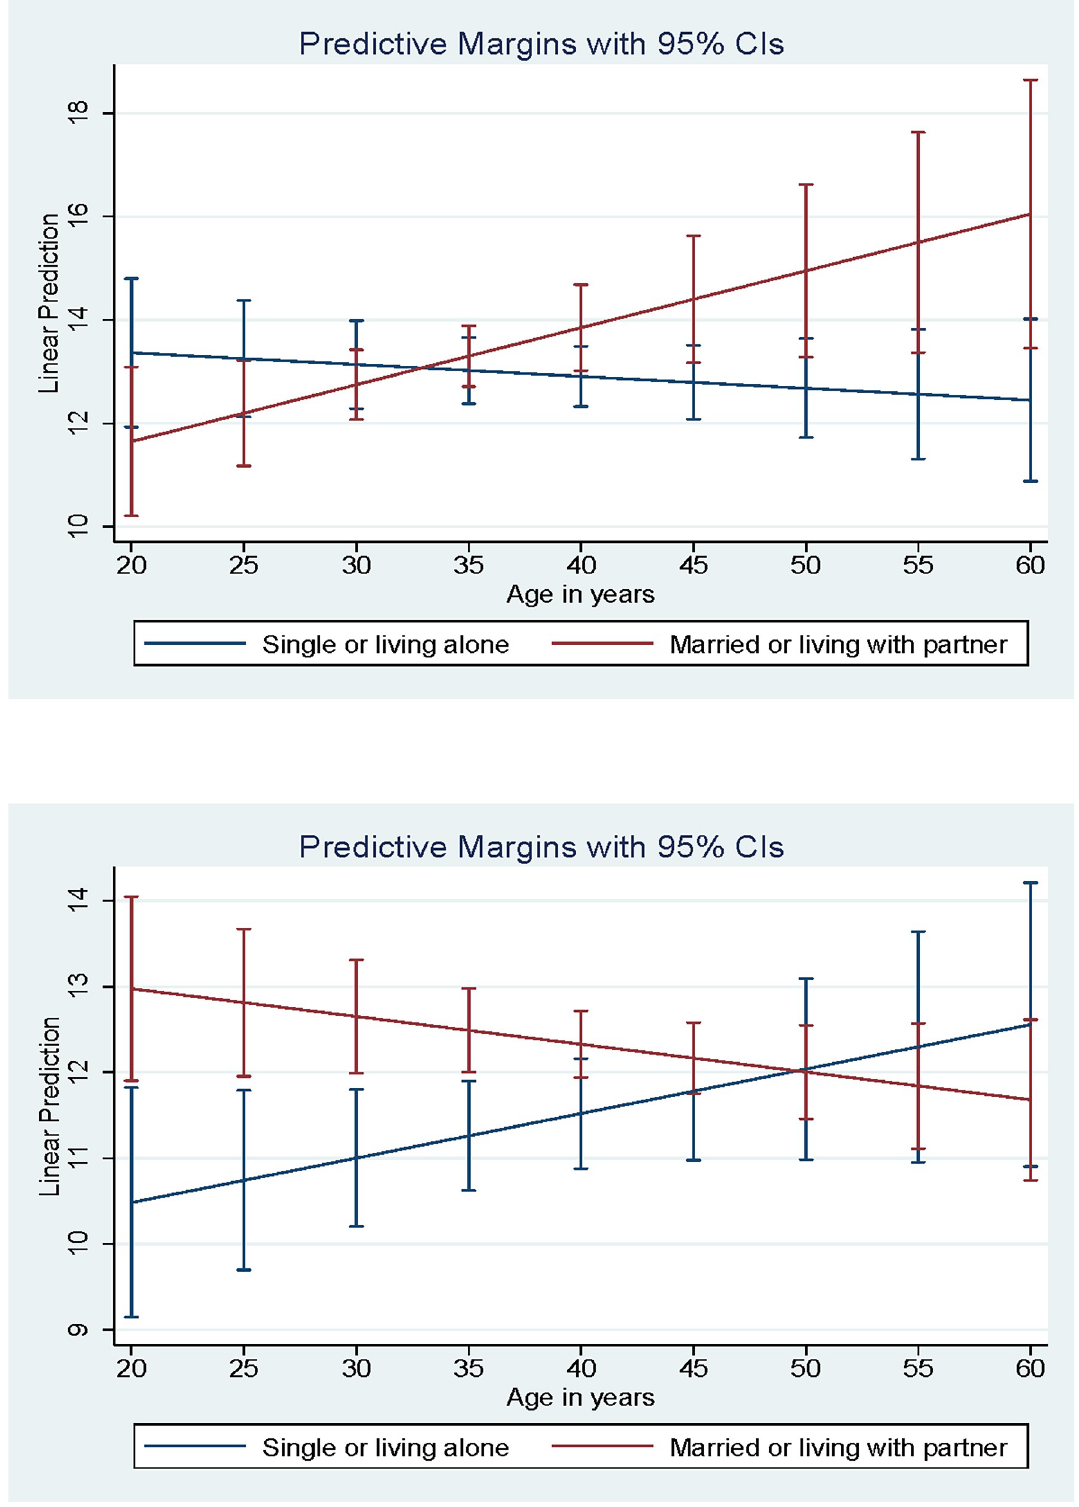
Fig 3. a) Interaction of Partner Status by Age for Women . Average Income = mean monthly income per respondent. Low Income = 1 standard deviation below the mean or 0 if negative. High Income = 1 standard deviation above the mean. b) Interaction of Partner Status by Age for Men